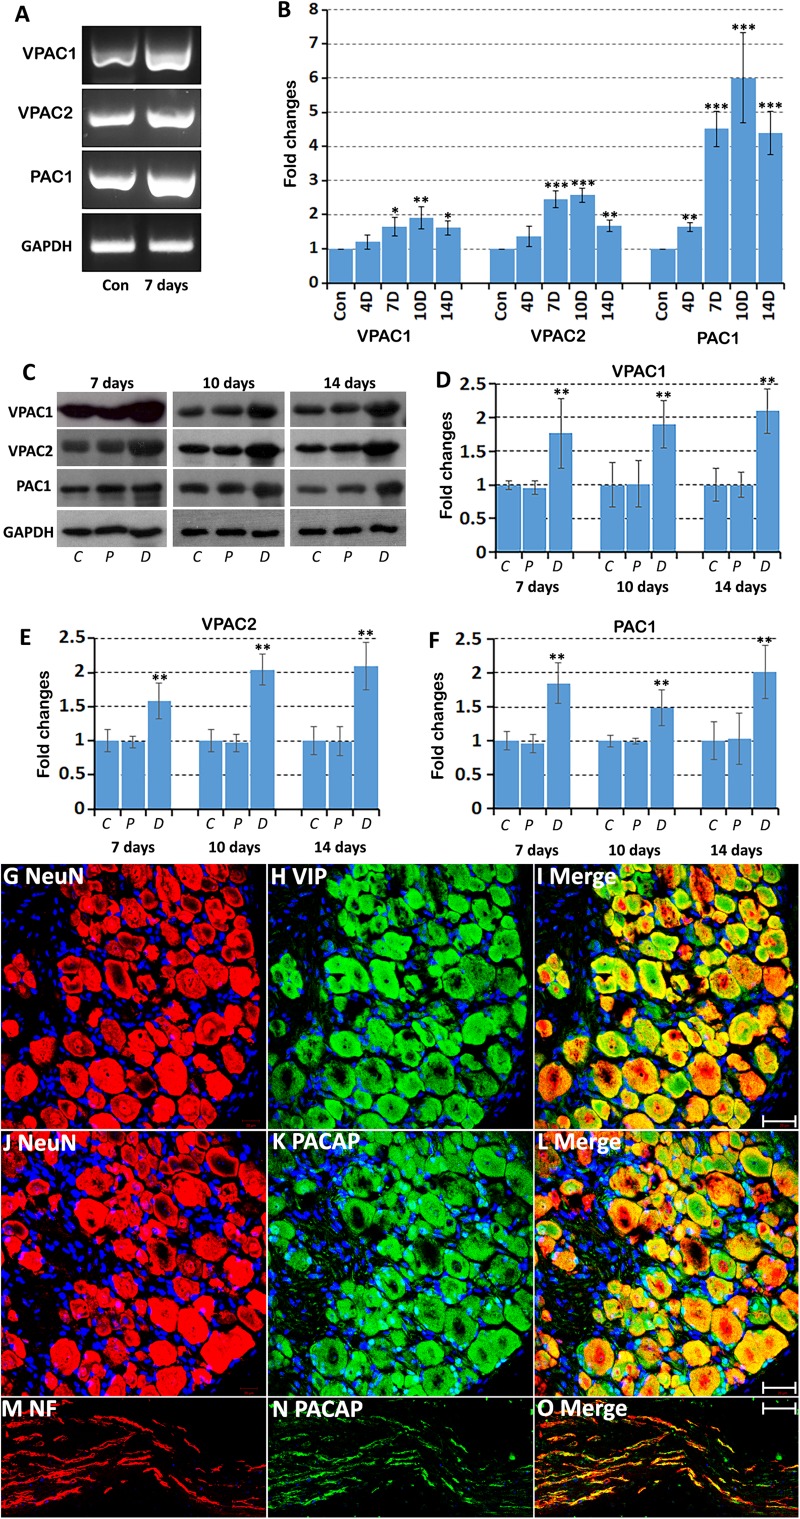
Up-regulation of VPAC1, VPAC2, and PAC1 following injury in the mouse distal sciatic nerve. (A) RT-PCR showing the presence of VPAC1, VPAC2, and PAC1 mRNAs in the intact (Con) mouse sciatic nerve and in the distal sciatic nerve 7 days after transection injury. (B) qRT-PCR showing VPAC1, VPAC2, and PAC1 mRNA up-regulation in the mouse distal sciatic nerve at 4, 7, 10 and 14 days following transection injury, n = 3. (C) Western blot showing VPAC1, VPAC2, and PAC1 protein expression in control uninjured (C), proximal (P), and distal (D) mouse sciatic nerve at 7, 10, and 14 days following transection injury. (D–F) Quantification of VPAC1 (D), VPAC2 (E), and PAC1 (F) protein levels from three independent western blot results showing VPAC1, VPAC2, and PAC1 protein up-regulation in the distal nerve stump. All samples were normalized to GAPDH and control samples were normalized to 1. ∗P < 0.05, ∗∗P < 0.01, ∗∗∗P < 0.001. (G–I) Double staining of Vasoactive Intestinal Peptide (VIP) with the neuronal marker NeuN showing that sensory neurons in the DRG express VIP at 7 days after sciatic nerve transection injury. (J–L) Double staining of Pituitary Adenylyl Cyclase Activating Peptide (PACAP) with the neuronal marker NeuN showing that sensory neurons in the DRG express PACAP 7 days after sciatic nerve transection injury. (M–O) Double staining of PACAP with neurofilament (NF) showing that PACAP is present in leading regenerating axons in the nerve bridge 7 days after sciatic nerve transection injury. Scale bars in I and L 20 μm. Scale bar in O 40 μm. Thirty six mice were used in A and B for RT-PCR and qPCR experiments. Twenty seven mice were used in C-F for western blot experiments. Three mice were used in (G–O) for immunostaining and three sections from each mouse were used for each staining.